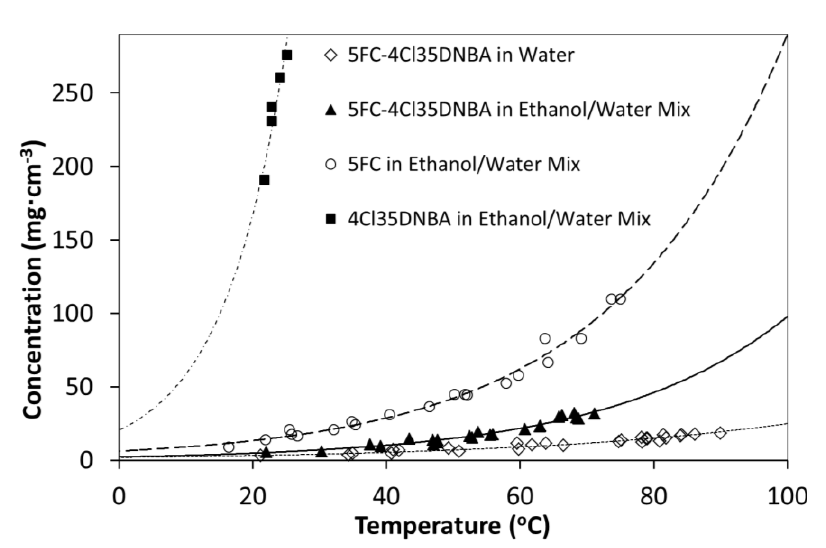
Figure 11. Comparison of solubility of 5FC-4Cl35DNBA co-crystal with 5FC and 4Cl35DNBA starting